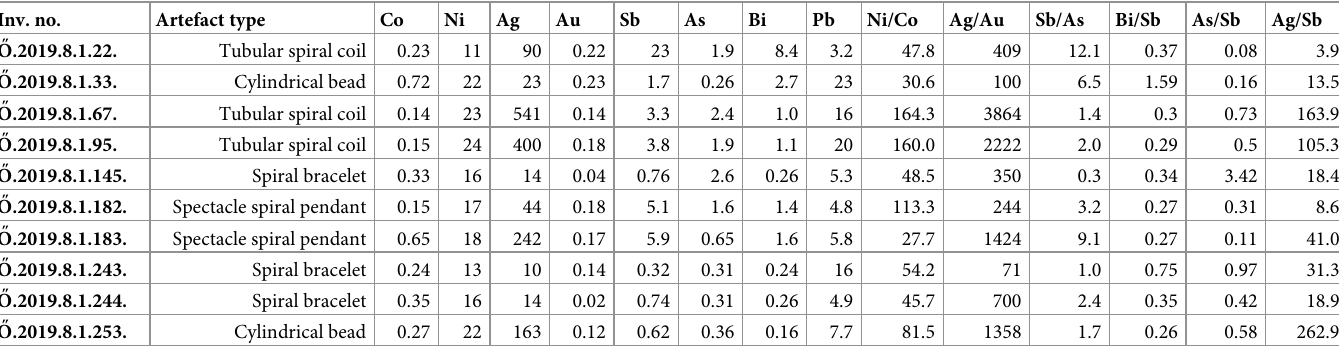
Table 2. Trace element concentrations (in ppm) of copper objects from the Magyaregres hoard. Inv. no.